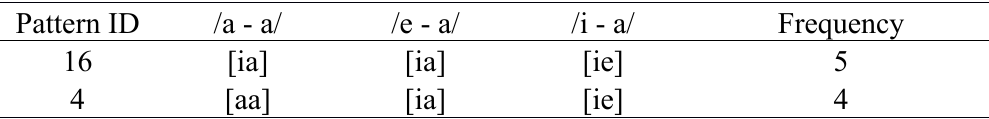
Table 5 . Attested opaque